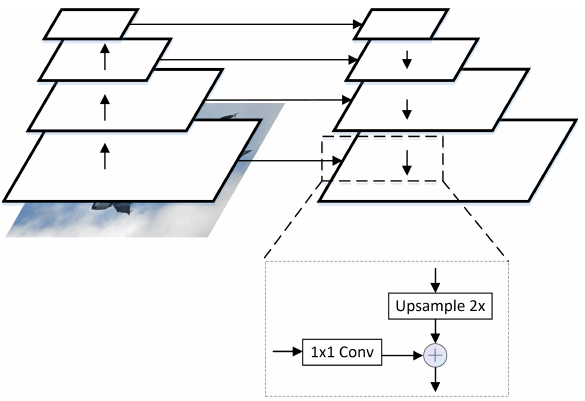
Figure 1. 4-level FPN. For the reasons of share head and feature fuse, FPN’s output features have the same channel number but different scale.